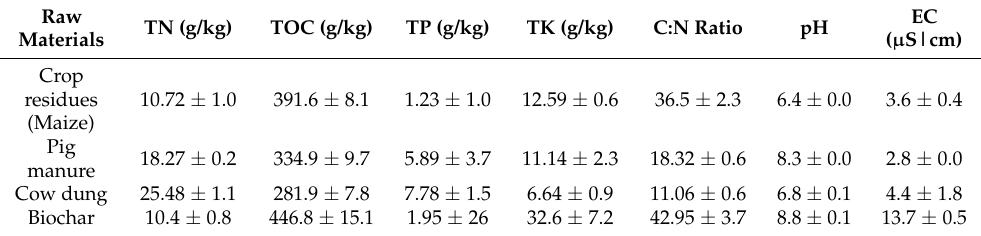
Table 1. Physicochemical properties of raw materials of vermicomposting (mean ± SD, n = 3). Raw